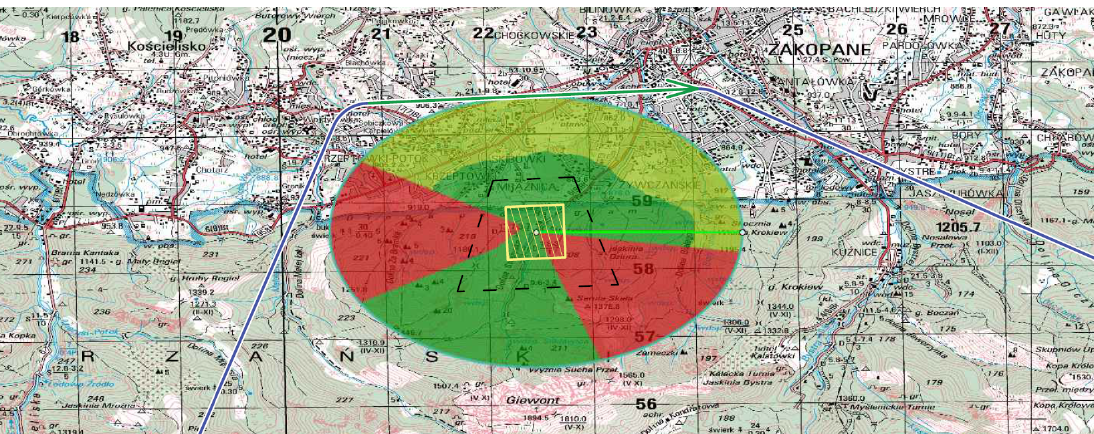
Figure 10. Part of a routing plan for UAV with sensor ISR tasks presented. Accurate flight trajectories determined using the Dubin algorithm. Table 1. VRPTW results for